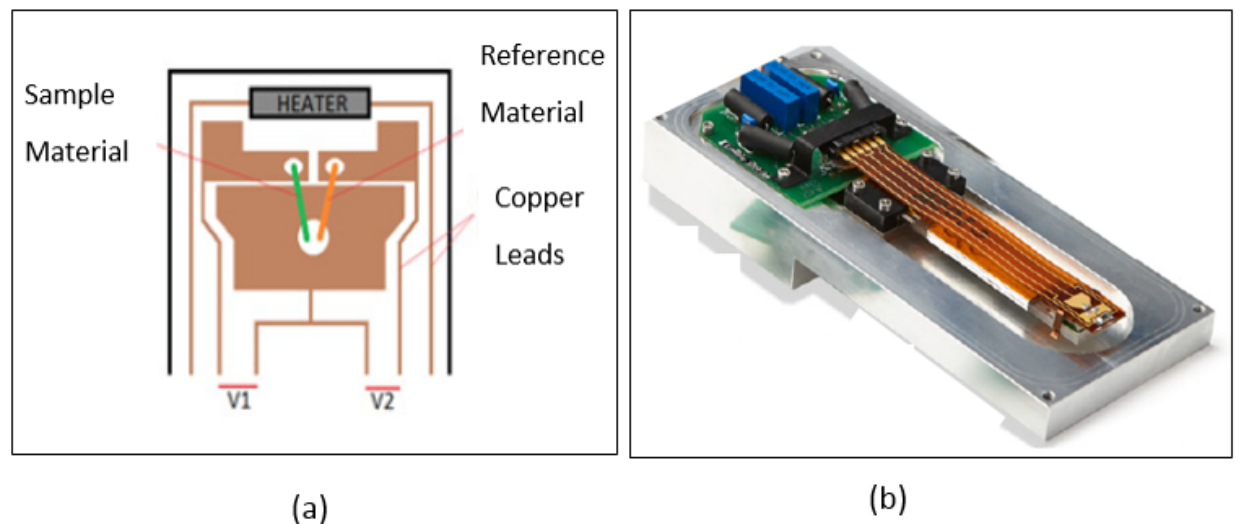
Figure 4. Commercial system (Seebeck thermal stage) of MMR Technologies Inc. (Figures are redrawn from [45] ( a ) Seebeck stage which has two pairs of thermos couples: green line is sample material and orange line is reference material. ( b ) MMR refrigerator which controls the temperature.